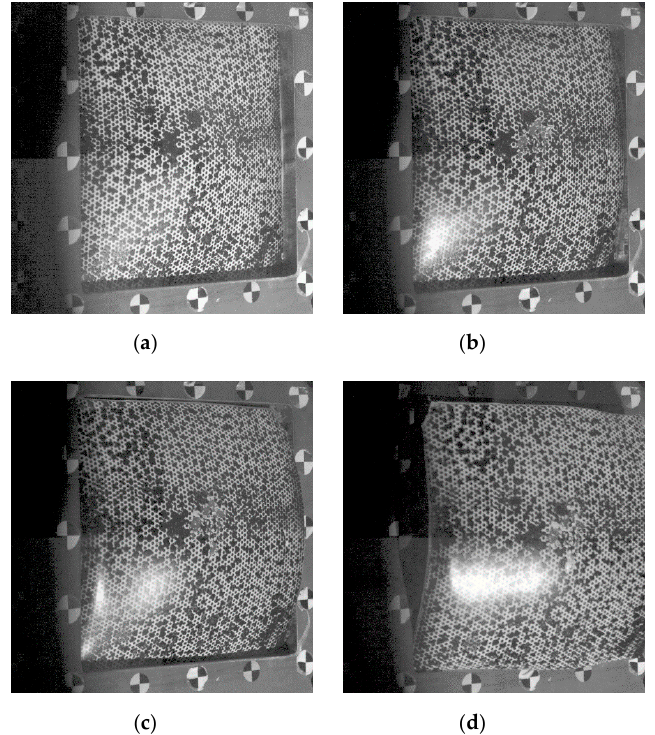
Figure 9. High-speed images of failure in test Sk_P15: (a) initiation of tearing along the vertical edges (t = 1.35 ms), (b) complete tearing along the vertical edges (t = 1.75 ms), (c) tearing starts in the (t = 1.35 ms), ( b ) complete tearing along the vertical edges (t = 1.75 ms), ( c ) tearing starts in the upper upper horizontal edge (t = 2.16 ms), and (d) complete failure along the entire frame (t = 2.97 ms). horizontal edge (t = 2.16 ms), and ( d ) complete failure along the entire frame (t = 2.97